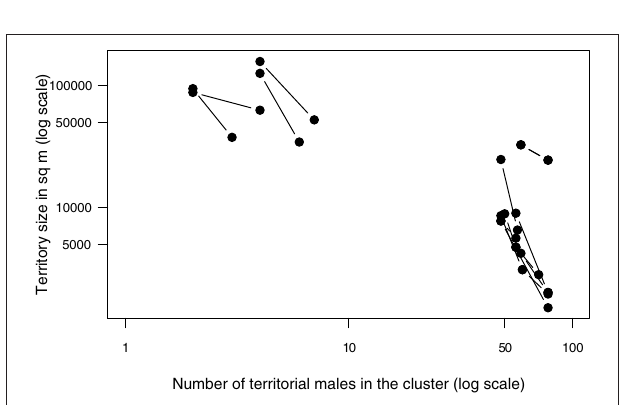
FIGURE 5 | The territory sizes of individual males changed apparently in response to the number of territorial males in the aggregation. Displayed here are examples of the change in the size of territories of known individuals in relation to the change in the number of males in the territory-cluster that the individuals belonged to. Each pair of data points connected by a line is the territory size of the same individual male measured on two different days when the number of territorial males in their territory-cluster differed. A subset of data is shown from small clusters (maximum number of territorial males ranging from 4 to 8) and from the large main lek. The relationship is strongly non-linear and hence the data have been log-transformed to obtain a better view of the pattern.